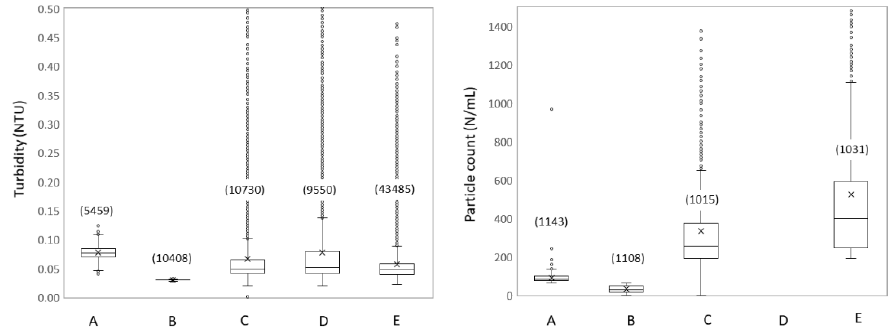
Figure 5. Range of turbidity ( left ) and total particle counts ( right ) at the treatment effluent (A) and four locations over water transport (B–D) and distribution (E) trajectory. Particle counts data from location D are not reported due to instrument failure. Box plots show the first, second (median), and third quartiles, whiskers show the data range, circles show outlier values, and a cross (x) indicates the mean value. The numbers of measurements are shown in brackets. Outliers for locations C (26 outliers for turbidity and 9 for particle counts), D (15 outliers for turbidity), and E (48 outliers for particle counts) up to 0.9 NTU and 2600 particles/mL are out of scale.